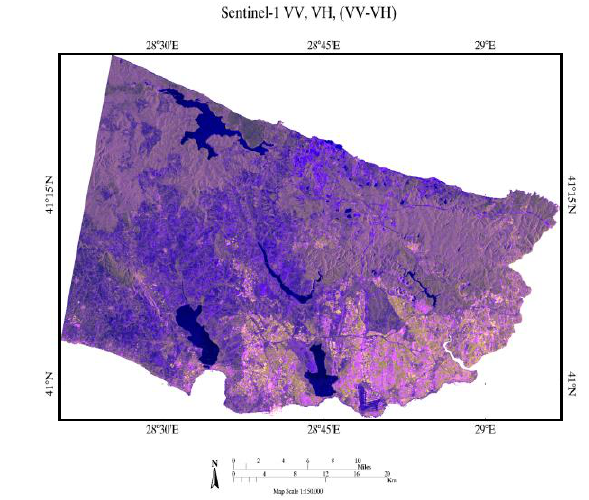
Figure 2. Composite image of Sentinel VV, VH, (VV-VH)